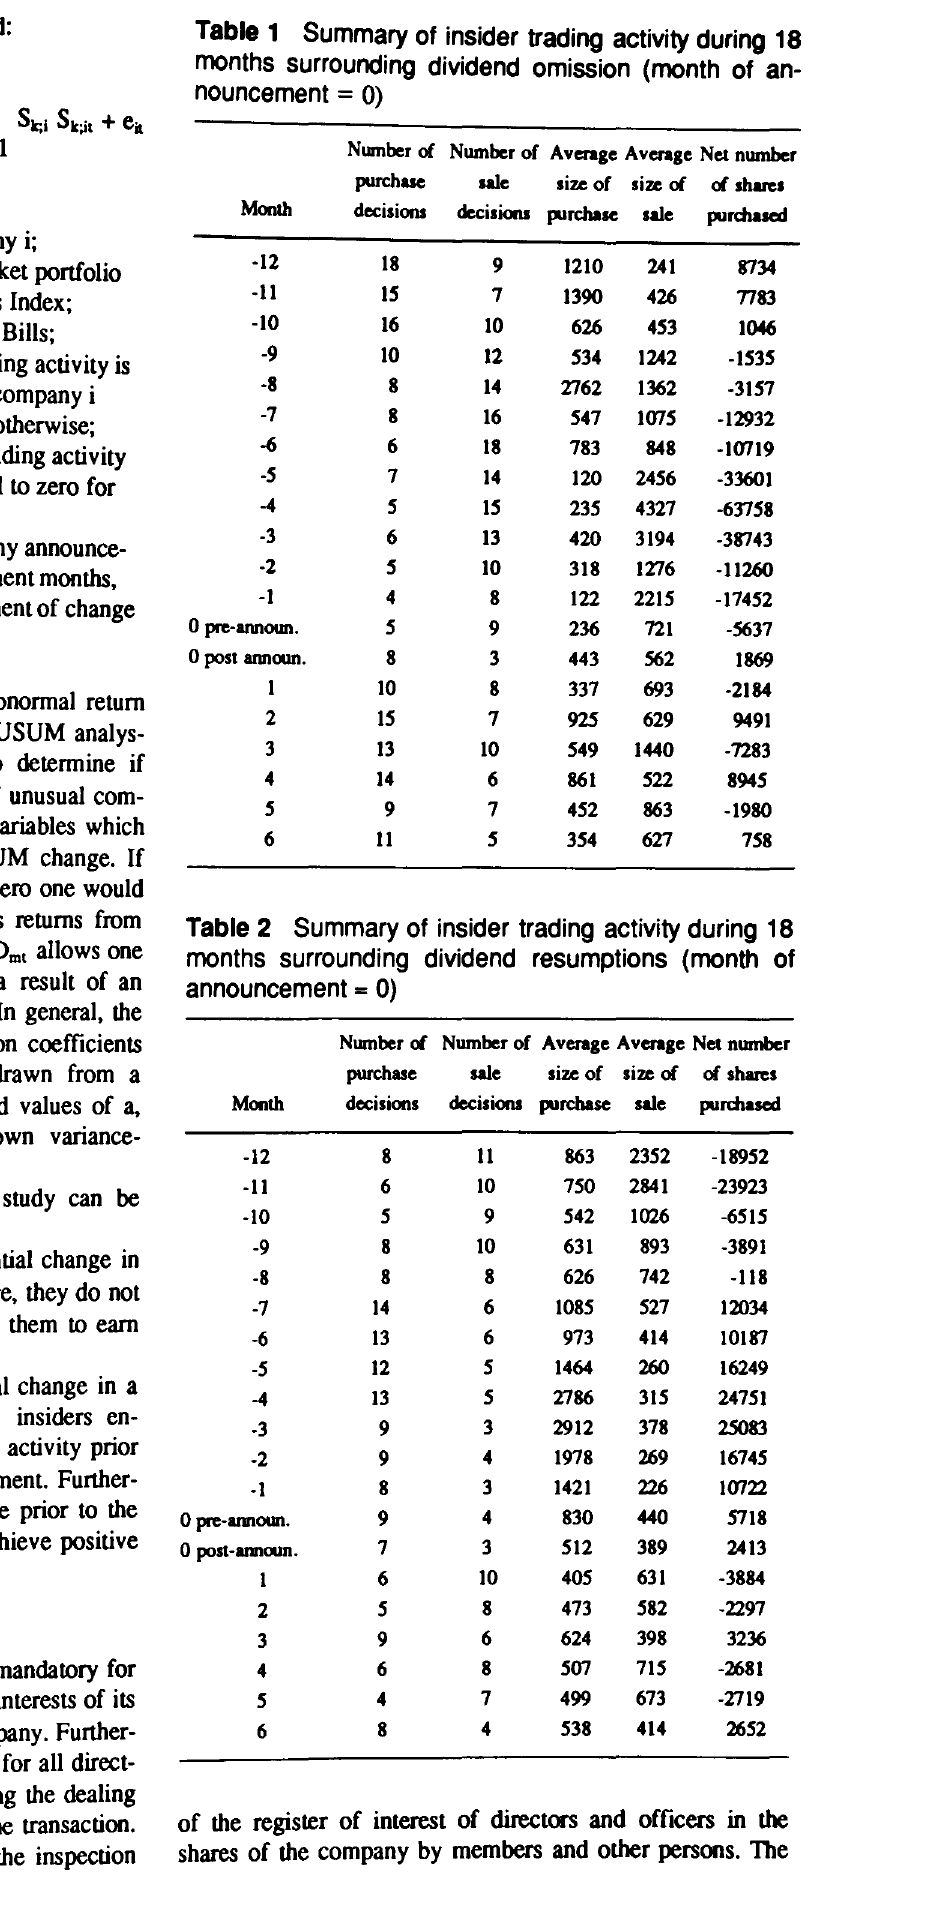
Table 1 Summary of insider trading activity during 18